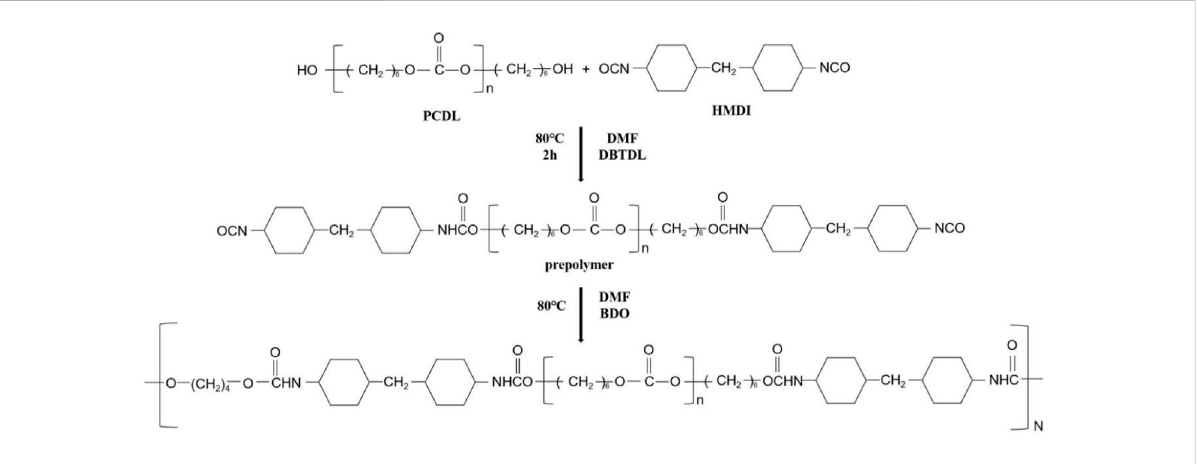
FIGURE 1 The synthetic route of